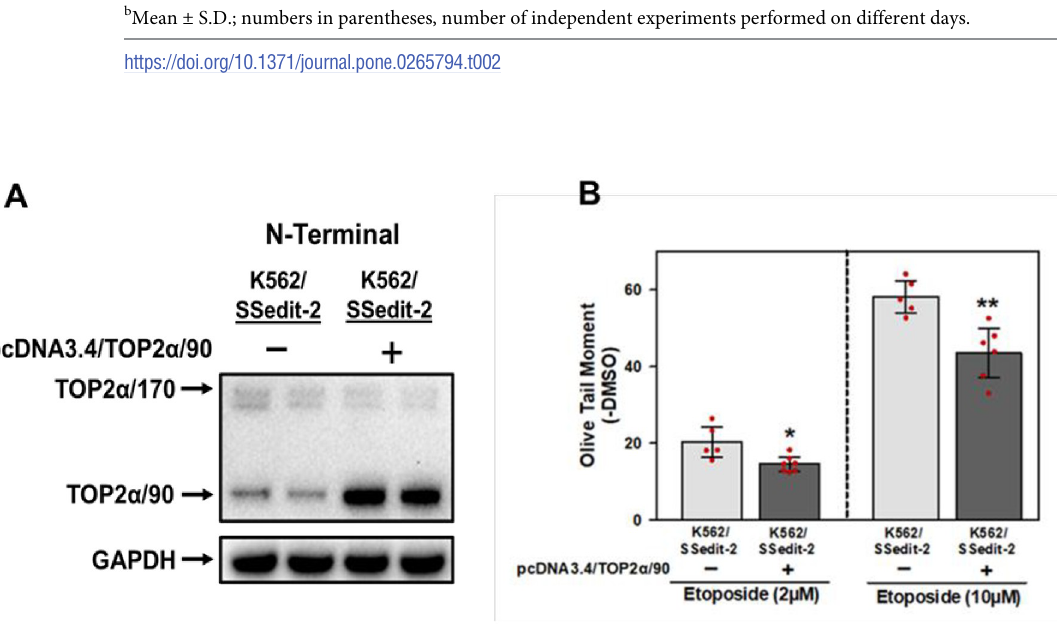
a Calculated from log-linear regression plots over 3–4 days of growth. b Mean ± S.D.; numbers in parentheses, number of independent experiments performed on different days.